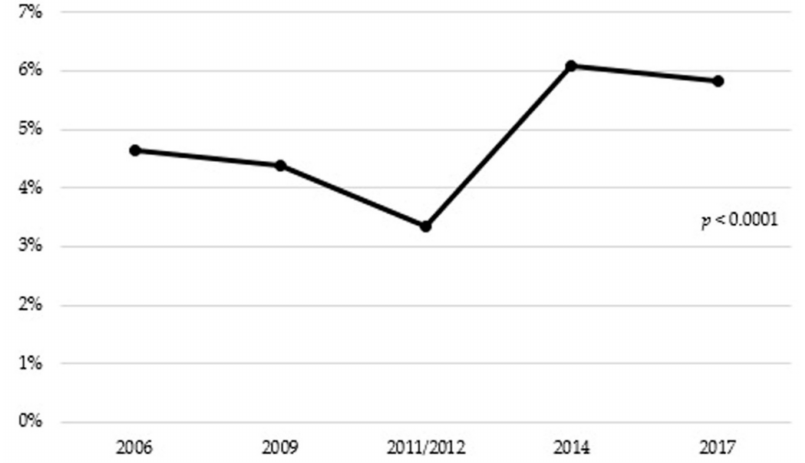
Figure 1. Antibiotic consumption in people aged 65 years or older in Spain